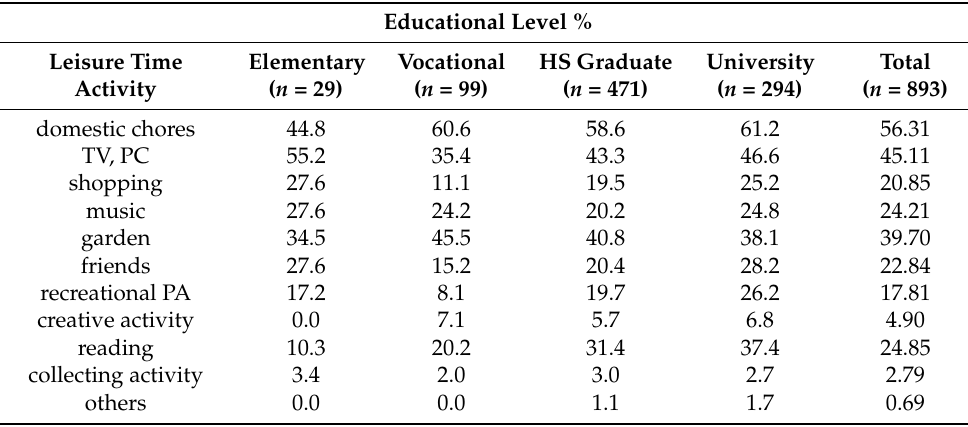
Table 4. Leisure time activity in relation to patients’ education.